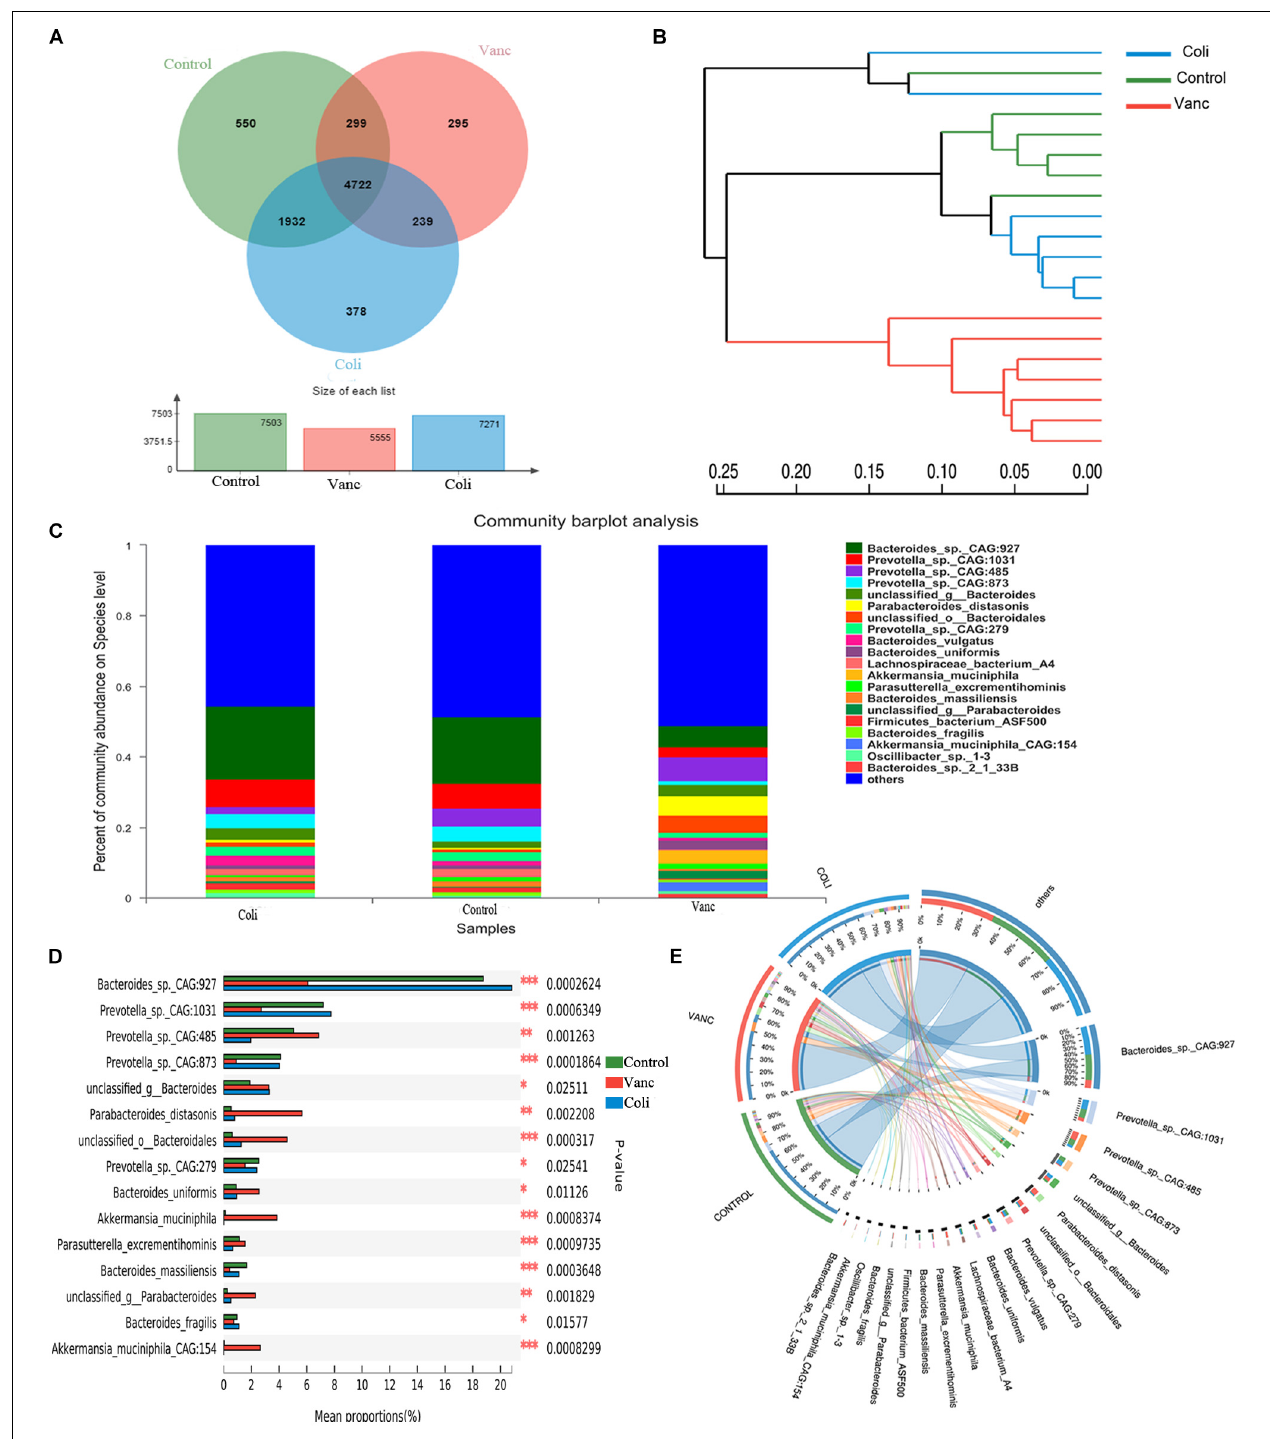
FIGURE 2 | Gut microbiome diversity is associated with response to PD-1 antibody immunotherapy in CT26 tumor-bearing mice. (A) Venn diagram of the total number of species shared between the three groups. (B) Hierarchical clustering tree on OUT level. (C) The community map of dominant species in three group at the level of species, the columns with different colors represent different species, and the length of the columns represents the proportion of species. (D) Bar plot of compositional differences at species level in the gut microbiome of three groups of mice by one-way ANOVA. (E) Circos of sample and species: a visual circle diagram describing the correspondence between samples and